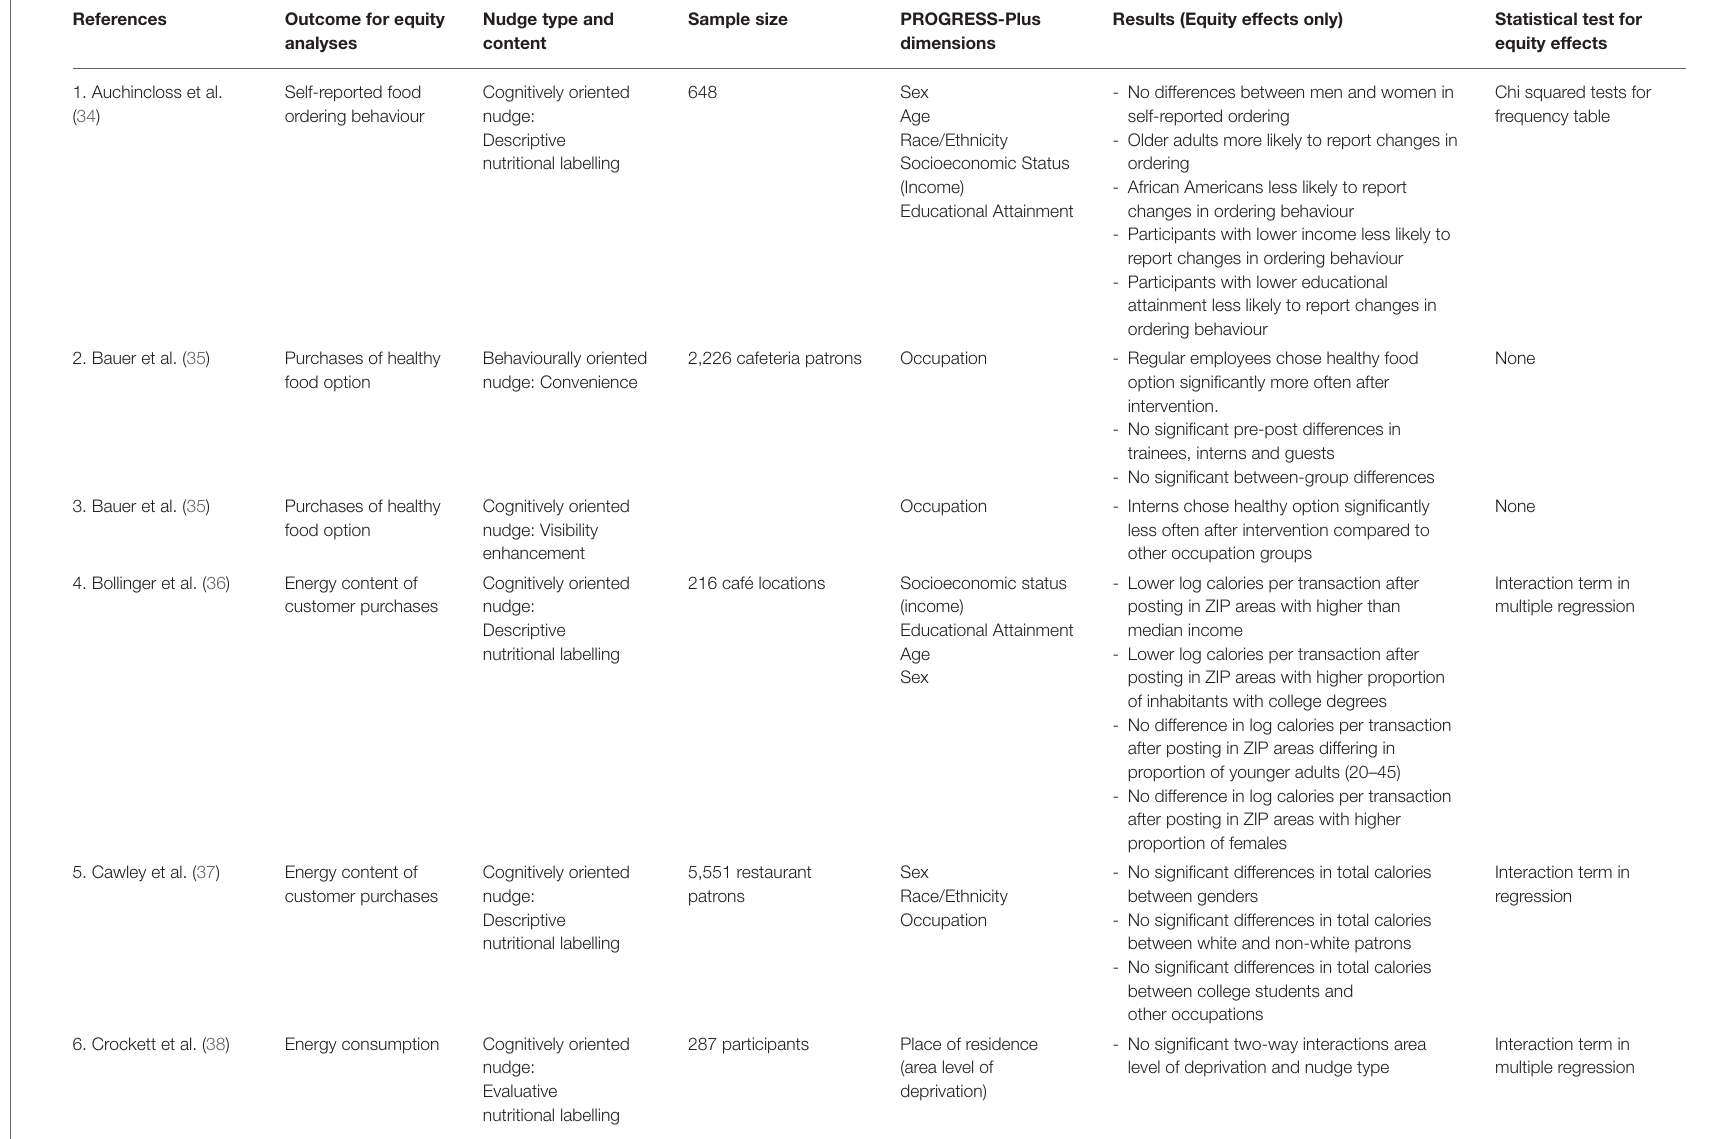
TABLE 1 | Studies included in